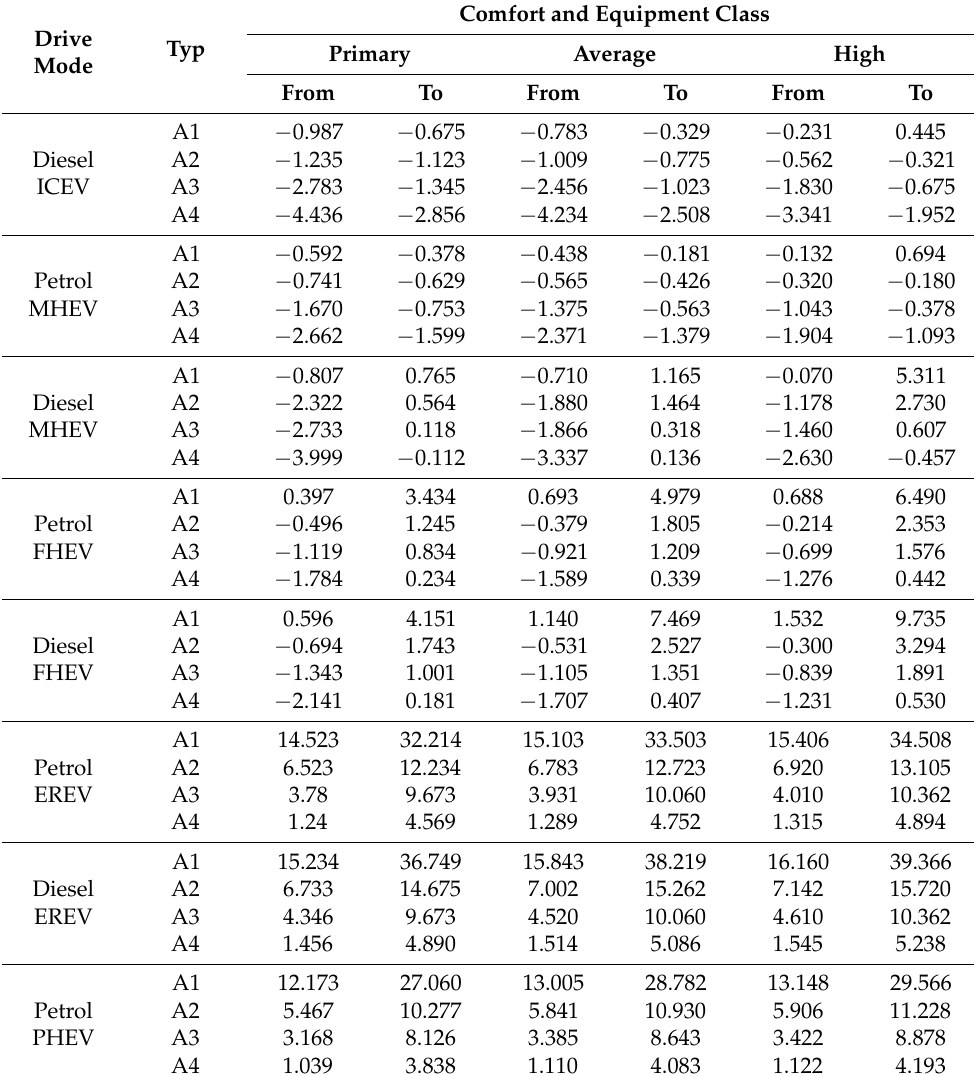
Table 6. Total cost of use of DTCO for various drives of SUVs depending on the equipment class and without taking into account the model covering aperiodic phenomena for a given group for 2020. Differential Total Cost of Ownership of DTCO for Given Vehicle Groups Compared to the